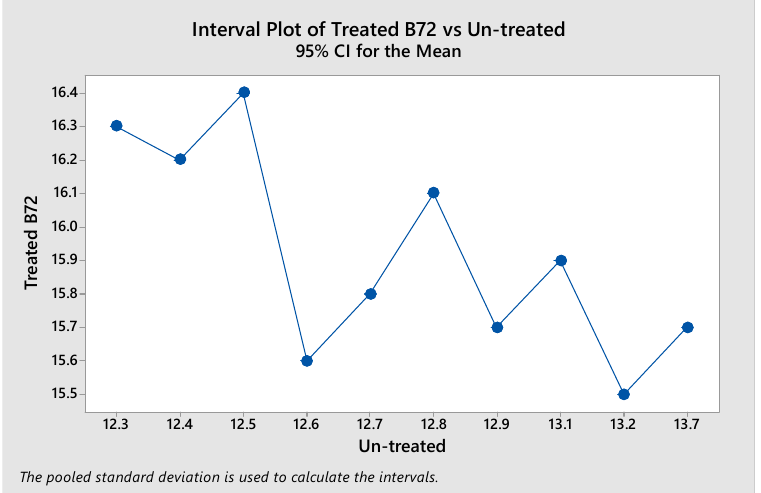
Figure 14. Interval plot of treated B72 vs. untreated medium-degraded lime values of Brinell hardness.